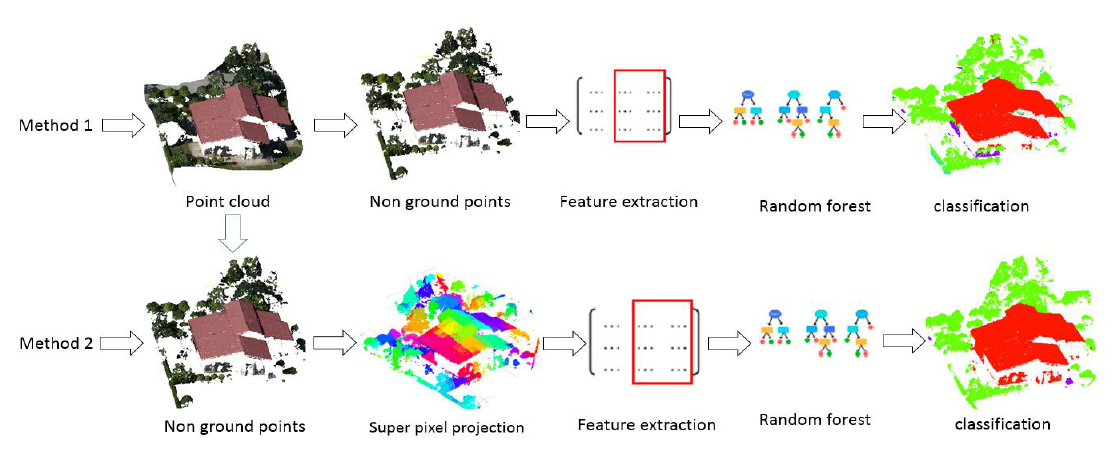
Figure 1. The general framework of the study